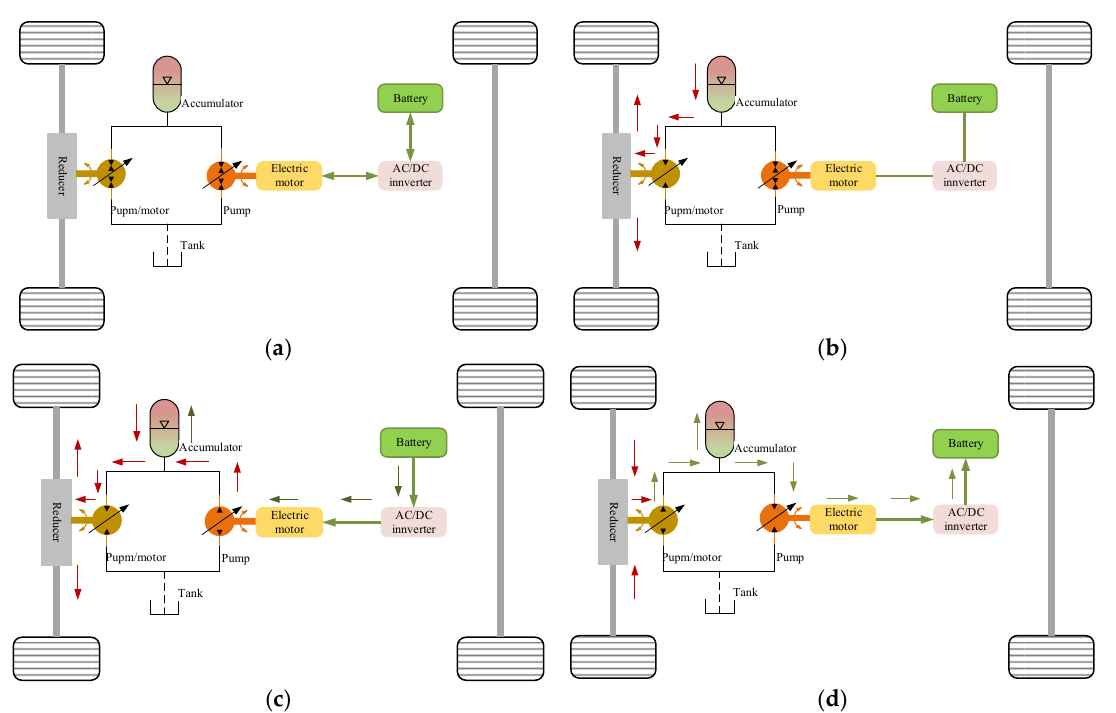
Figure 6. Configuration and energy flow of hydraulic electric hybrid vehicles [48,49,53,71]: ( a ) series hybrid; ( b ) launch; ( c ) acceleration and cruising; ( d ) regeneration.